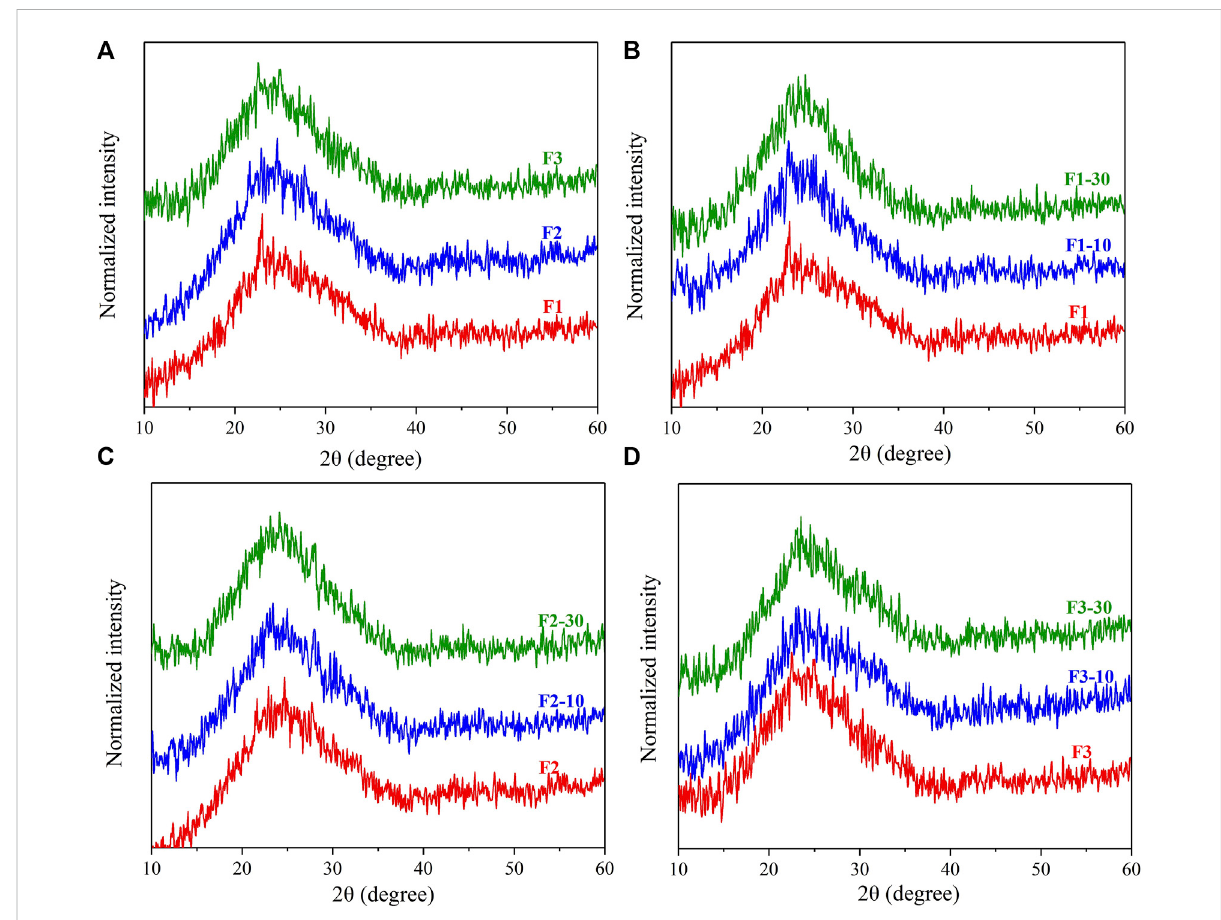
FIGURE 5 XRD spectra of soot in different magnetic fi elds. (A) Without magnetic fi eld, (B) 21% O 2 , (C) 26% O 2 , (D) 31% O 2 .